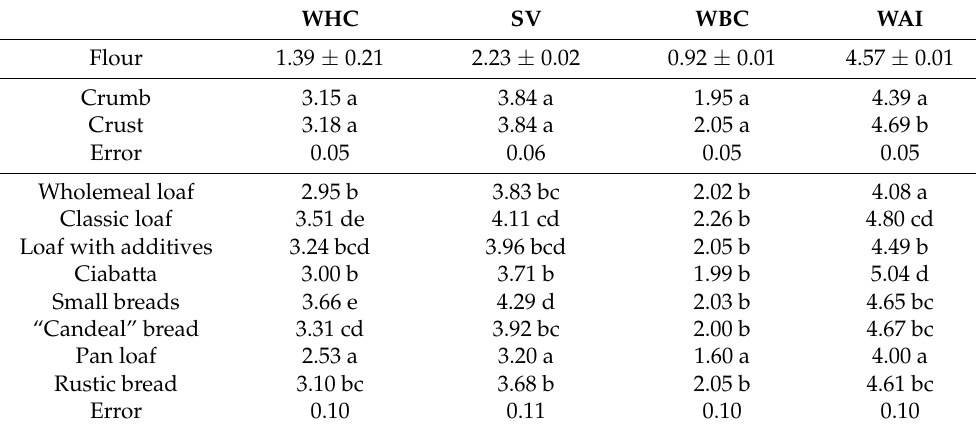
Table 3. Hydration properties of the flours